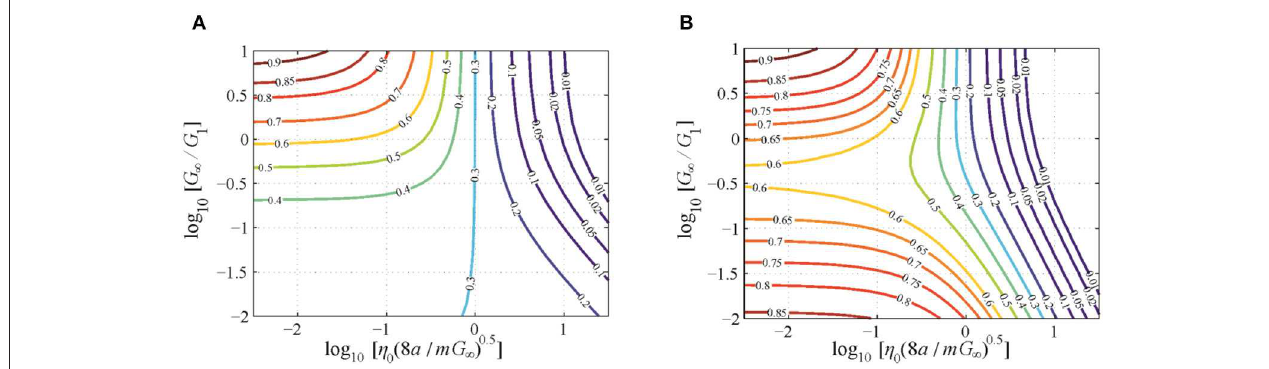
FIGURE 4 | Contour line diagrams of the coefficient of restitution as a function of the governing nondimensional parameters for the impact of a cylindrical flat punch onto a Kelvin–Maxwell solid; approximate solutions based on the solution for the Kelvin solid. (A) Based on Equation (12) for the damping parameter D . (B) Based on Equation (13) for the damping